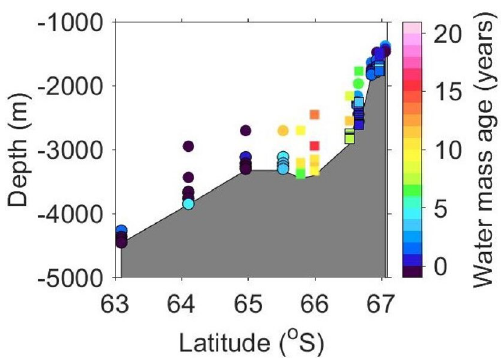
Figure 8. Vertical distribution of AABW ages (neutral density: γ n > 28.27 kg m −3 ) along Wild Canyon (white line in Fig. 1). Data were obtained during cruises of KH19-01 (circles) and KH20-01 (squares). The symbols of new AABW ( θ < − 0.4 °C) 10 are outlined in black. The figure was generated using MATLAB (version R2021a; https:// www. mathw orks. com/ produ cts/ matlab.